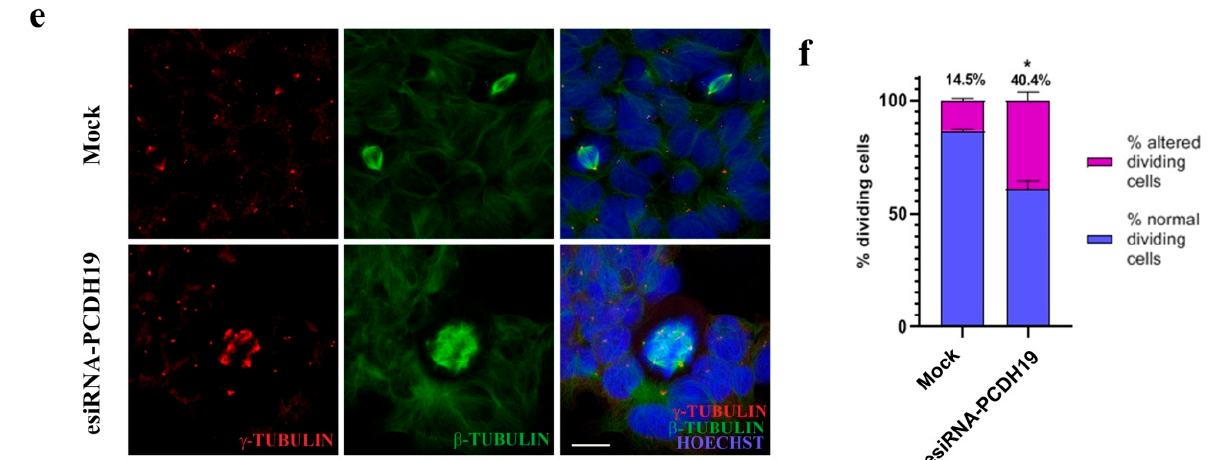
Figure 6. Analysis of the mitotic spindle in CTRL, PCDH19mut and mixed cell cultures and in PCDH19 silenced iPSCs. ( a ) Confocal micrographs and 3D reconstruction of immunofluorescence assays in CTRL, PCDH19mut and mixed iPSCs showing a comparable localization of PCDH19 and γ -tubulin. Scale bar = 5 µ m; ( b ) Immunofluorescence analyses for γ -tubulin and β -tubulin showing the mitotic spindle structures in CTRL, PCDH19mut and mixed iPSCs. Scale bar = 5 µ m; ( c ) Graph showing the quantification of anomalous metaphases in dividing cells. More than 1000 cells were analyzed for each sample. Data are presented as mean ± SEM (normalized to control), n = 3. ** p < 0.005, according to unpaired t -test; ( d ) Western blot assay and a bar graph quantification (of three independent experiments) display the amount of PCDH19 levels in CTRL (Mock) and PCDH19 silenced iPSCs (siRNA-PCDH19). Data are presented as mean ± SEM (normalized to control), n = 3. ** p < 0.005; ( e ) Images of immunofluorescence analyses for γ -tubulin and β -tubulin highlighting the mitotic spindle structures in PCDH19 silenced (siRNA-PCDH19) and CTRL iPSCs (Mock). Scale bar = 5 µ m; ( f ) Graph depicting the quantification of altered metaphases in dividing cells in CTRL (Mock) and in silenced iPSCs (siRNA-PCDH19). More than 500 cells were analyzed for each sample. Data are normalized to control and presented as mean ± SEM. Statistically significant difference is calculated with unpaired t -test (* p < 0.05), n =